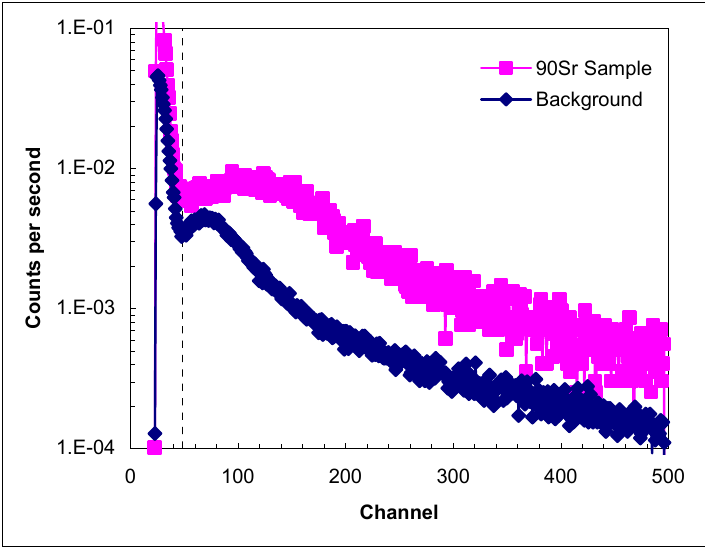
Figure 9. Pulse height spectrum for PMTs in two-end coincidence mode. The pulse height represents the sum of both